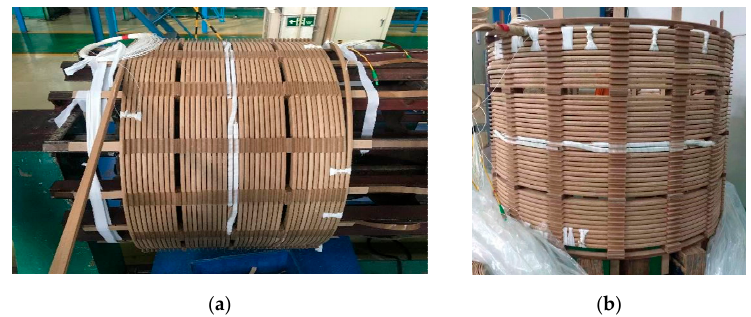
Figure 10. ( a ) The installation of fibre-optic composite transformer winding model and ( b ) the completed transformer winding model.